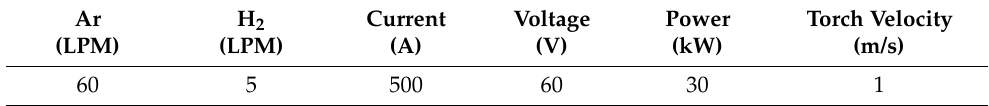
Table 1. Plasma torch operation parameters.